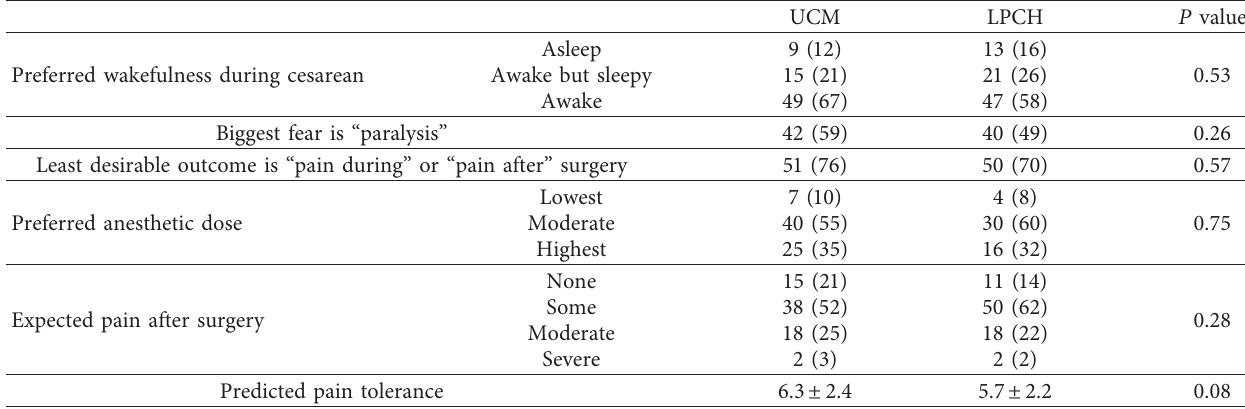
Table 3: Cesarean anesthesia preferences and expectations from the current University of Chicago Medicine survey compared to those from the previous Lucile Packard Children’s Hospital, Stanford study ∗ .